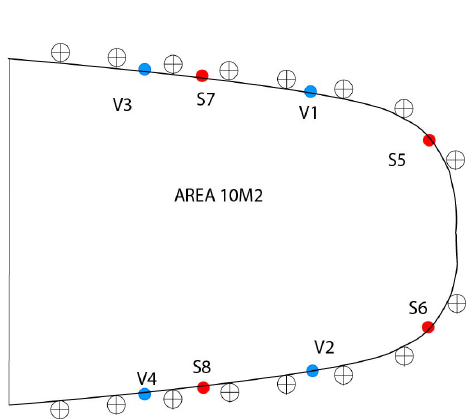
Figure 9. Measuring points of vertical and horizontal